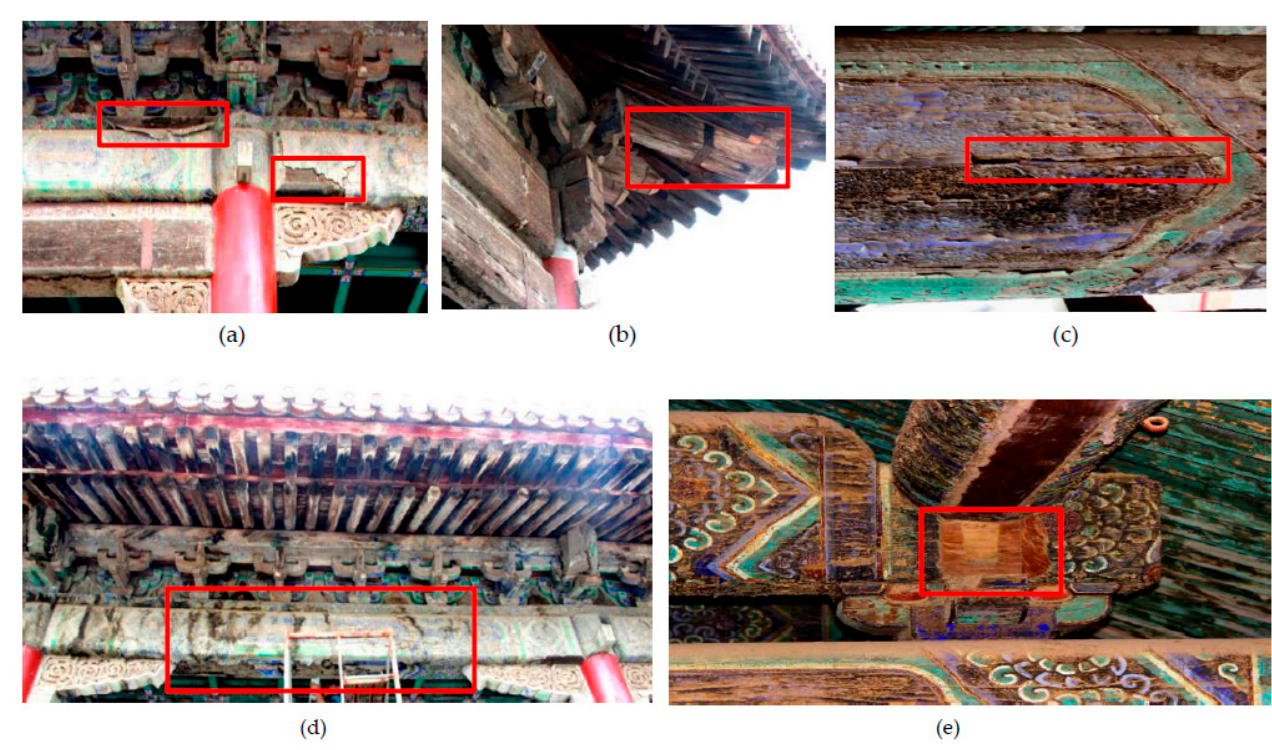
Figure 2. Surface damage to the building: ( a ) Wall shedding; ( b ) Mold in rafters; ( c ) Beam splitting; ( d ) Kick-up of frame; ( e ) Missing components.